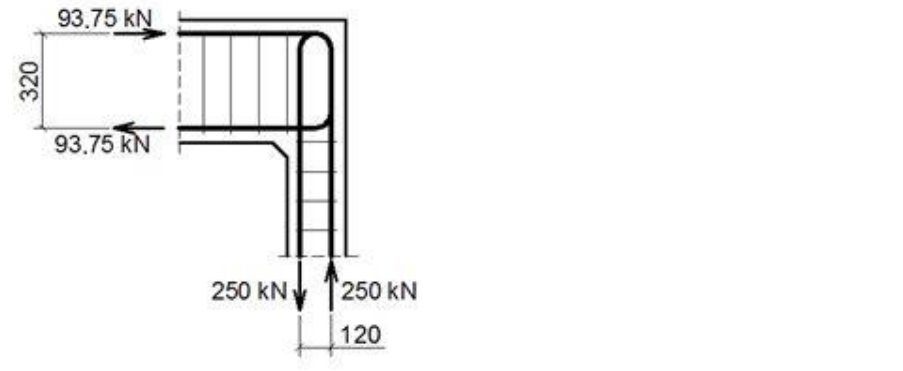
Figure 15. Loading scheme for the case of elements with different cross section heights; dimensions in (mm).